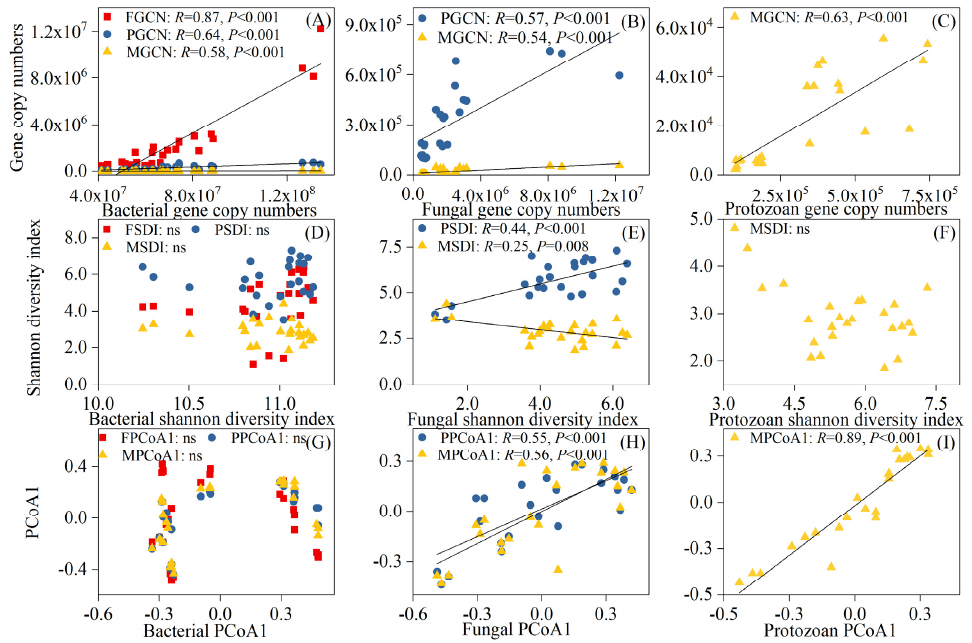
Figure 6. Relationship of gene copy numbers ( A – C ), Shannon diversity index ( D – F ), and PCoA1 ( G – I ) between bacteria, fungi, protozoa, and metazoa. FGCN: fungal gene copy numbers; PGCN: protozoan gene copy numbers; MGCN: metazoan gene copy numbers; FSDI: fungal Shannon diversity index; PSDI: protozoan Shannon diversity index; MSDI: metazoan Shannon diversity index; FPCoA1: fungal PCoA1; PPCoA1: protozoan PCoA1; MPCoA1: metazoan PCoA1. n = 24 (four treatments, three replications per treatment, and two soil depths).